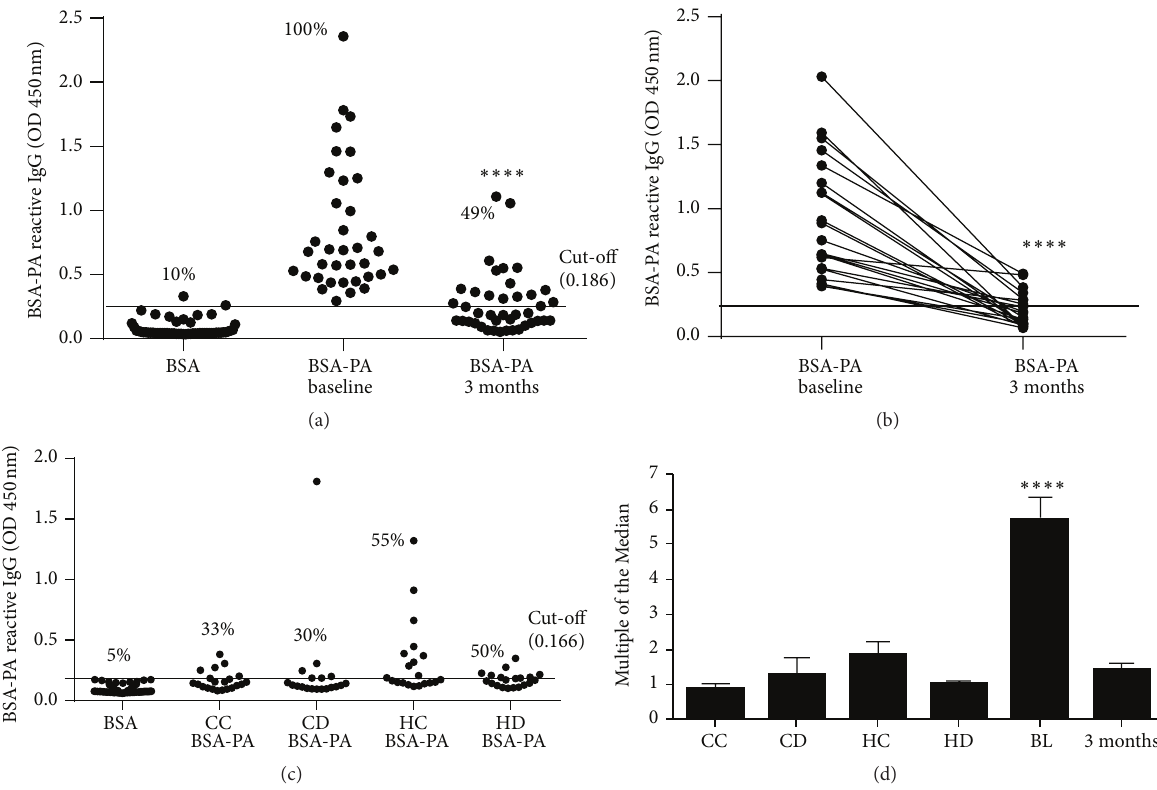
Figure 5: Detection of anti-LCSFA antibodies in human serum. (a) Anti-LCSFA IgG in serum of Hispanic En Balance participants with type 2 diabetes is reduced following 3 months of diabetes education. Each data point represents the mean optical density of anti-LCSFA IgG antibodies detectable by ELISA. The cut-off value for positive antibody reactivity against BSA-PA ( > 0.186) was defined as an absorbance greater than two standard deviations above the mean value for BSA. The frequency of sera positive for each group is indicated as a percent on the graph. (b) Paired data from the 21 En Balance participants with both baseline (mean ± SEM = 1.05 ± 0.121 ) and 3-month serum (mean ± SEM = 0.25 ± 0.030 ) samples. The black lines connect data points belonging to the same participant. Data was analyzed by Mann-Whitney (for (a)) and Wilcoxon test (for (b)). (c) Frequency of anti-LCSFA IgG Abs in serum samples from Bioserve biorepository. CC: